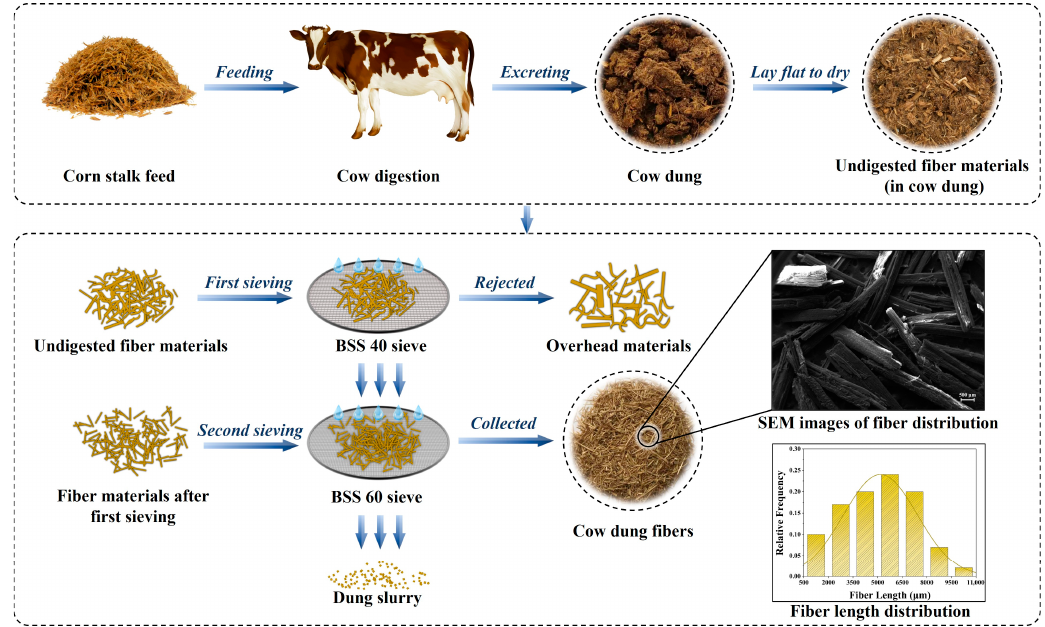
Figure 1. The schematic diagram of the preparation process of the cow dung fibers.